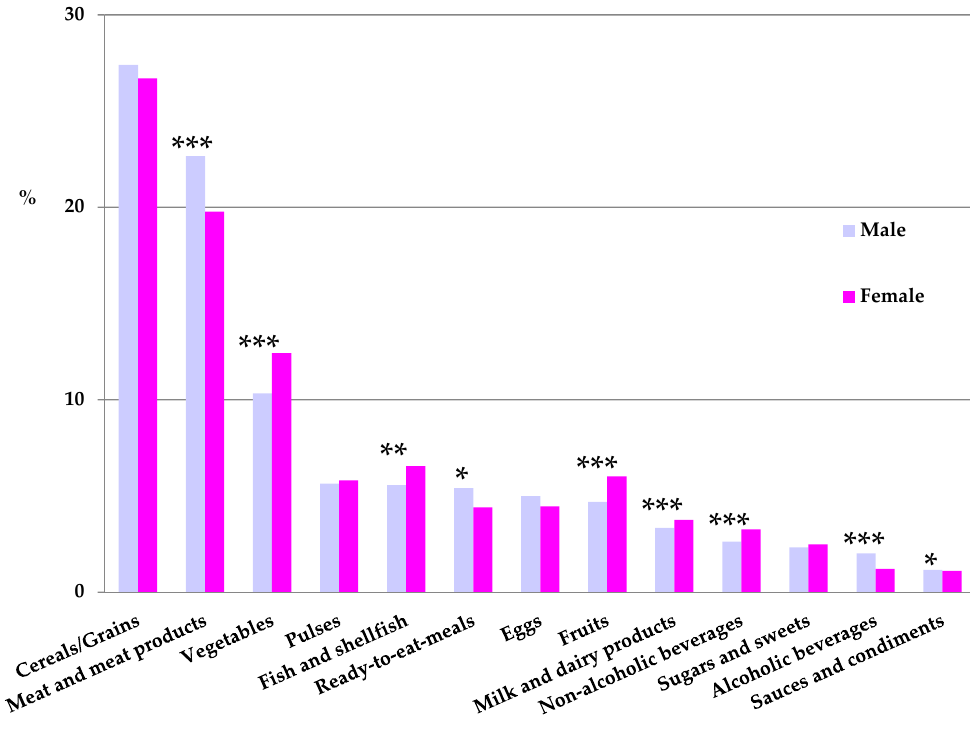
Figure 2. Contribution of food and beverages to iron intake by gender. * p < 0.05 difference vs. women (Mann-Whitney’s U test); ** p < 0.01 difference vs. women (Mann-Whitney’s U test); *** p < 0.001 difference vs. women (Mann-Whitney’s U test).